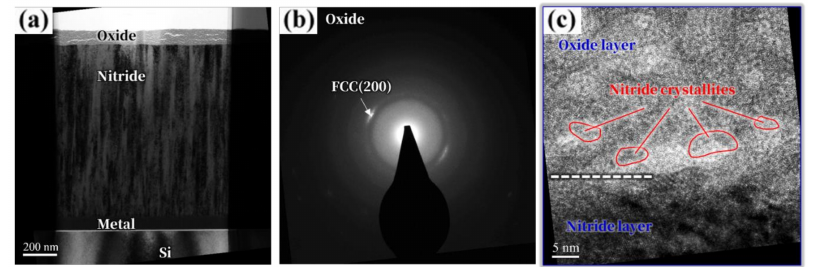
Figure 5. Cross-sectional TEM micrographs of the as-deposited (CrTaTiVZr)N coatings after annealing at 400 ◦ C in air. ( a ) bright-field image, ( b ) SAD pattern of the oxide layer, ( c ) HRTEM lattice image.